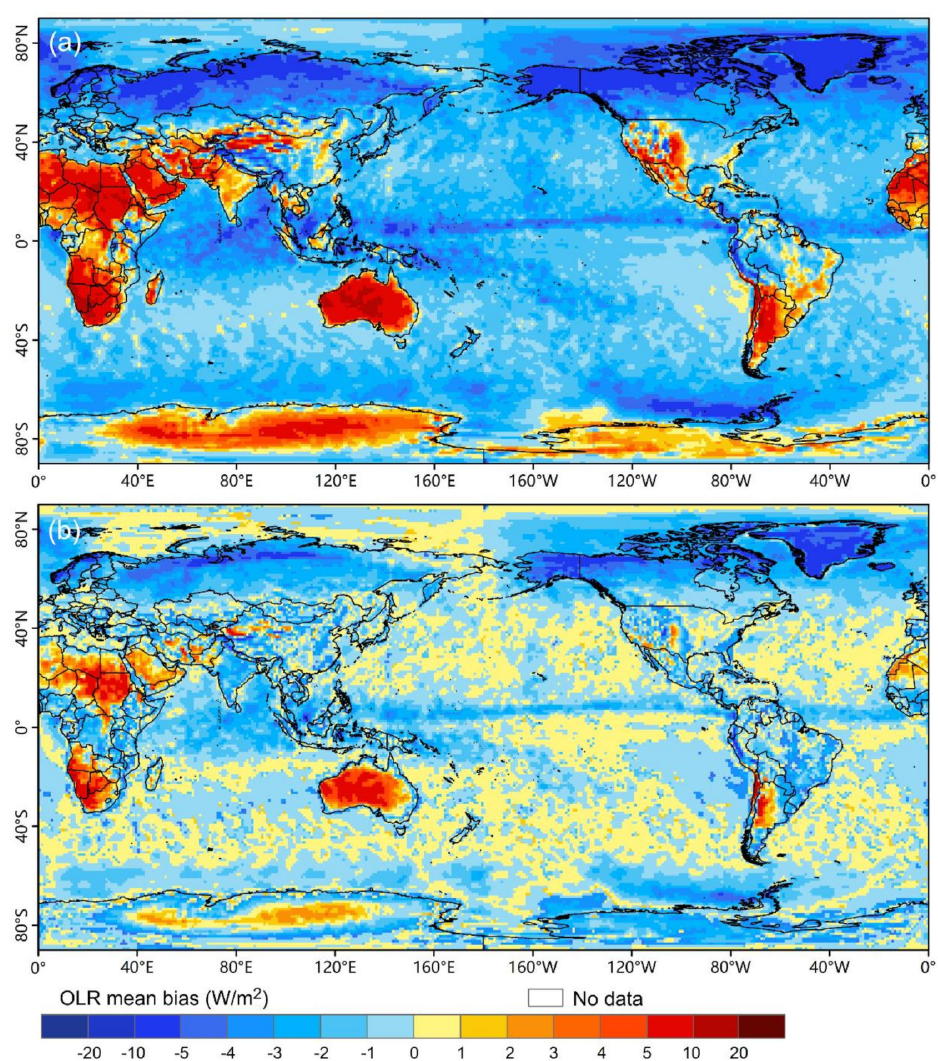
Figure 1. Spatial distributions of the daily mean bias (MB) ( a ) between the Fengyun-3D (FY-3D) outgoing longwave radiation (OLR) data ( F _OLR ) and the NOAA OLR data ( N _OLR ) and ( b ) between the corrected F _OLR and N _OLR from May 2019 to December